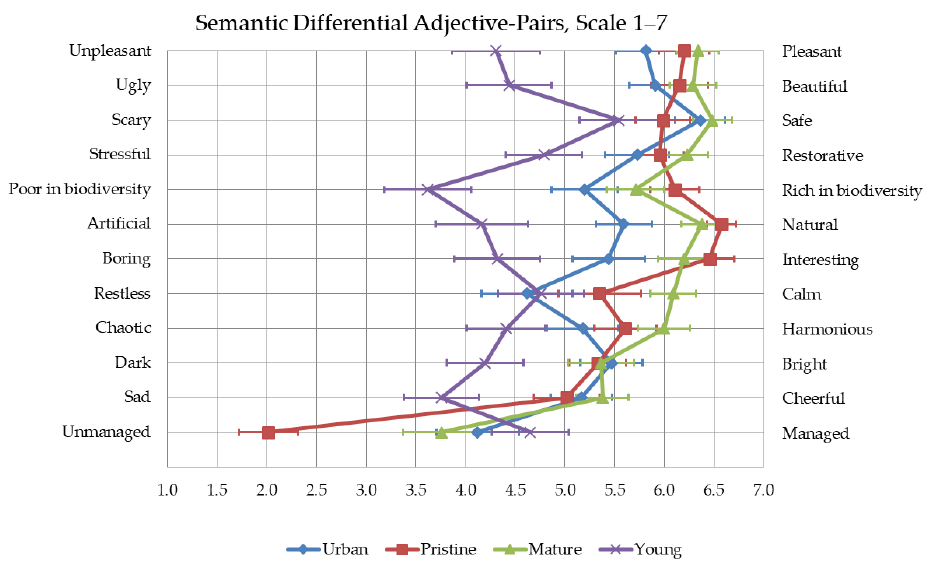
Figure 9. The mean values of adjective-pairs in four different forests. Error bars represent 95% confidence intervals.